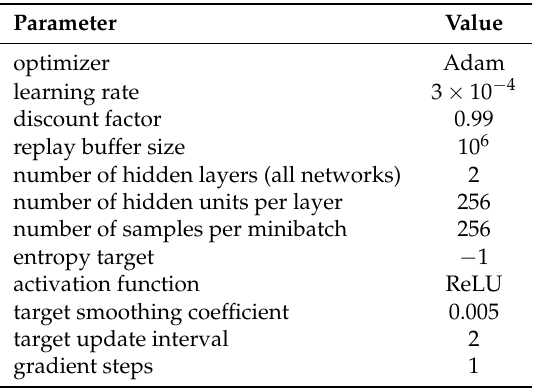
Table 2. Hyperparameters of the SAC